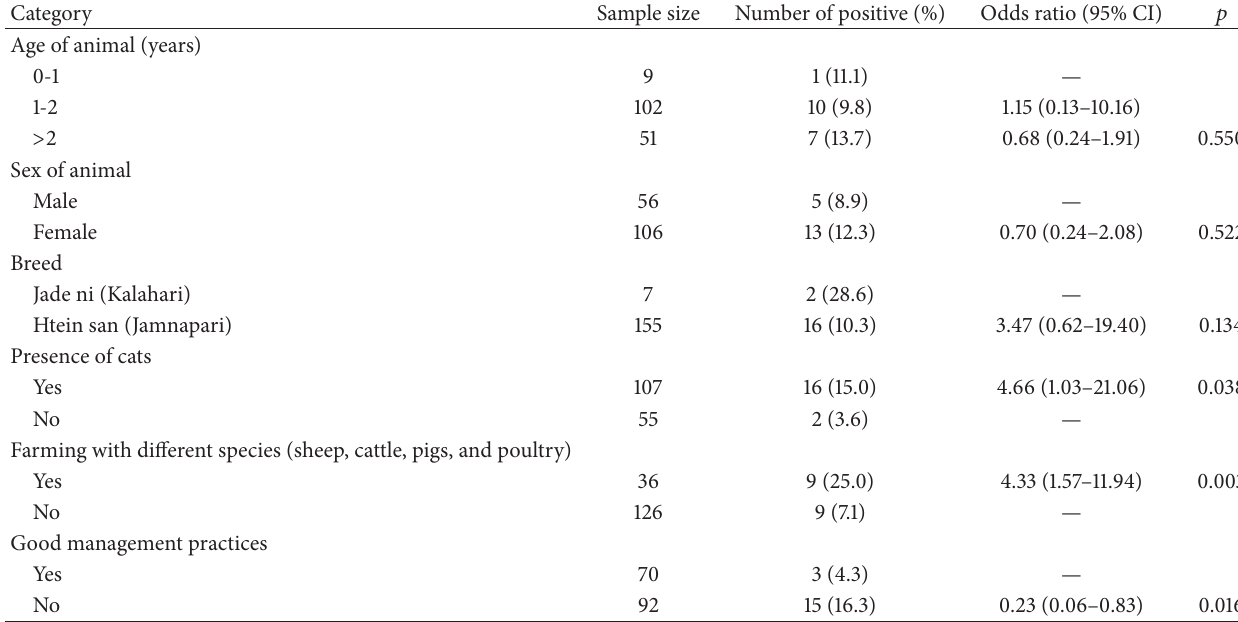
Table 3: Factors associated with T. gondii infection in goats in Pyawbwe